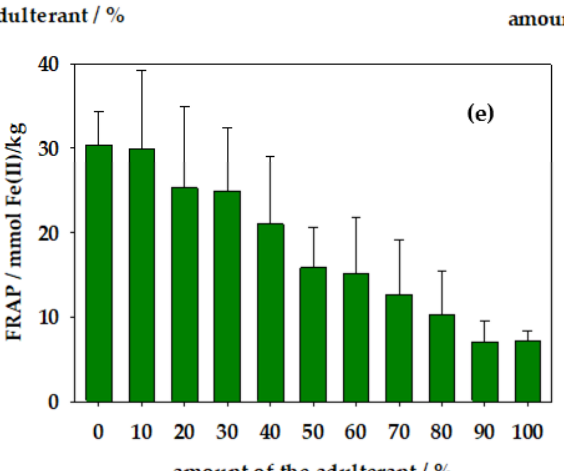
Figure 1. Average values of physical and chemical properties of pure honey samples and prepared glucose syrup adulterations: ( a ) moisture content, ( b ) conductivity, ( c ) total color change, ( d ) total phenolic content, and ( e ) antioxidant activity measured by FRAP method.